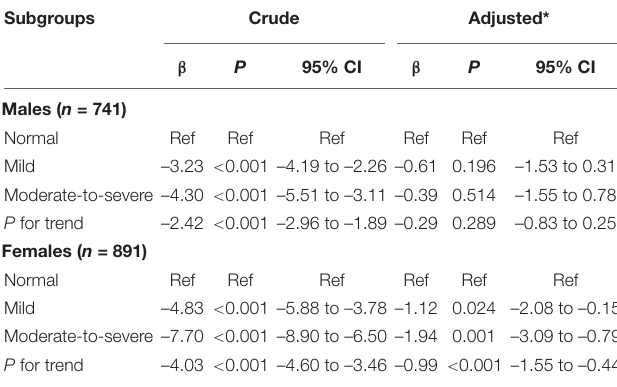
TABLE 3 | The association of malnutrition with cognitive function stratified by